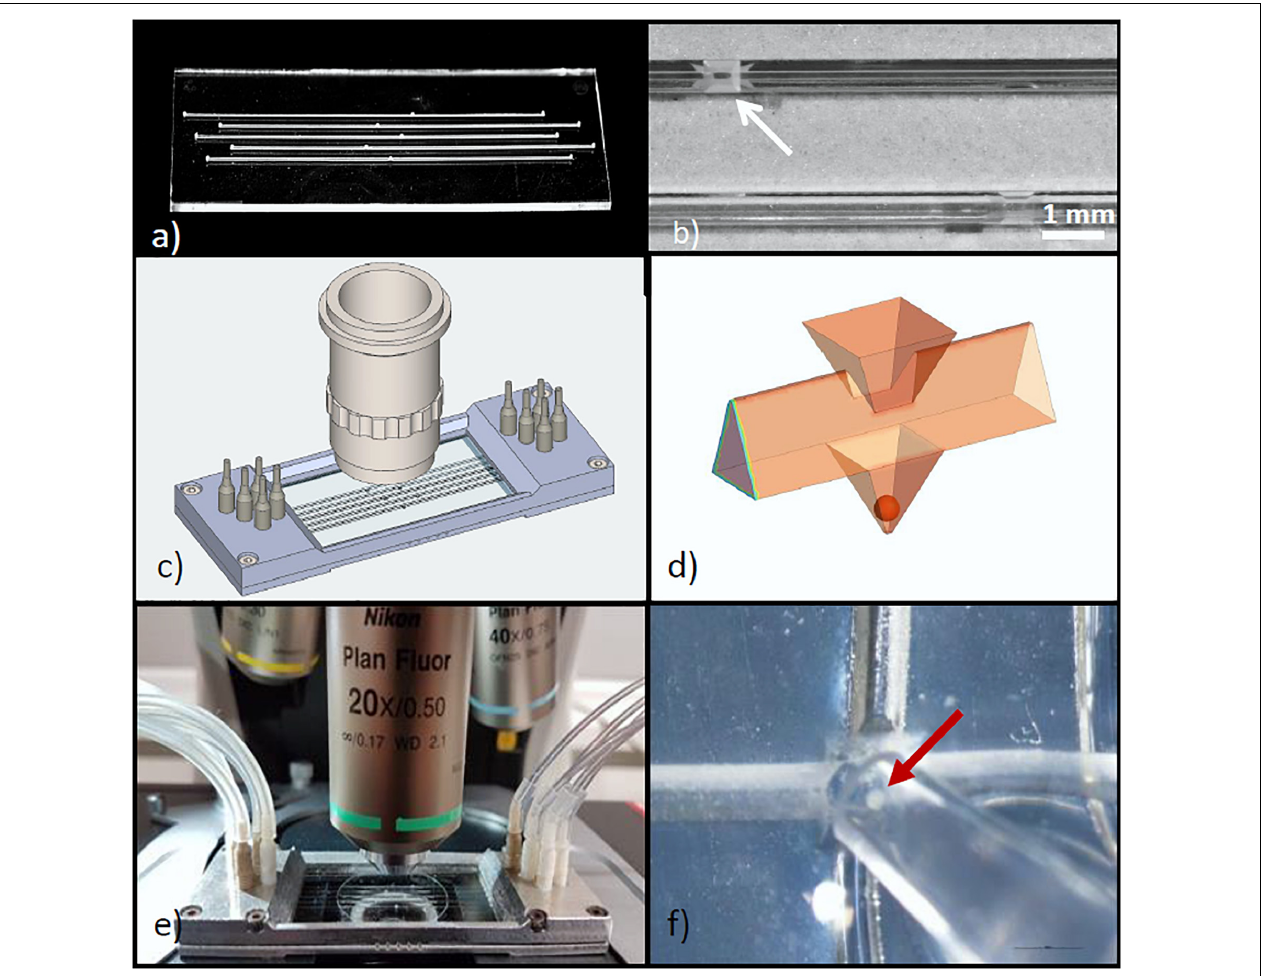
FIGURE 1 | Design of the microfluidic system for parallel perifusion of single isolated islets. (a) View of the glass chip containing 5 parallel microchannels, each with a single well of 500 µ m depth. The chip consists of 2 layers bonded together after structuring. The total thickness of the chip is 1.4 mm. (b) Detail of the chip surface, showing the inlet (arrow) through which the islet can be inserted into the well. (c) Isometric drawing of the parallel perifusion slide after attaching the glass chip to the metal frame. The metal frame holds PVC fittings to connect with the tubing. For size comparison a microscope objective is placed above the part where the wells are located. (d) 3D schematic view of the islet inlet, the microchannel shape and the pyramidal well below the inlet containing a spheroidal islet of 150 µ m diameter. (e) Entire perifusion slide with attached tubing placed on the stage of an upright fluorescence microscope. The cover slip sealing the inlets is clearly visible. (f) A mouse islet (arrow) being inserted into the inlet above the well by use of an Eppendorf pipette.